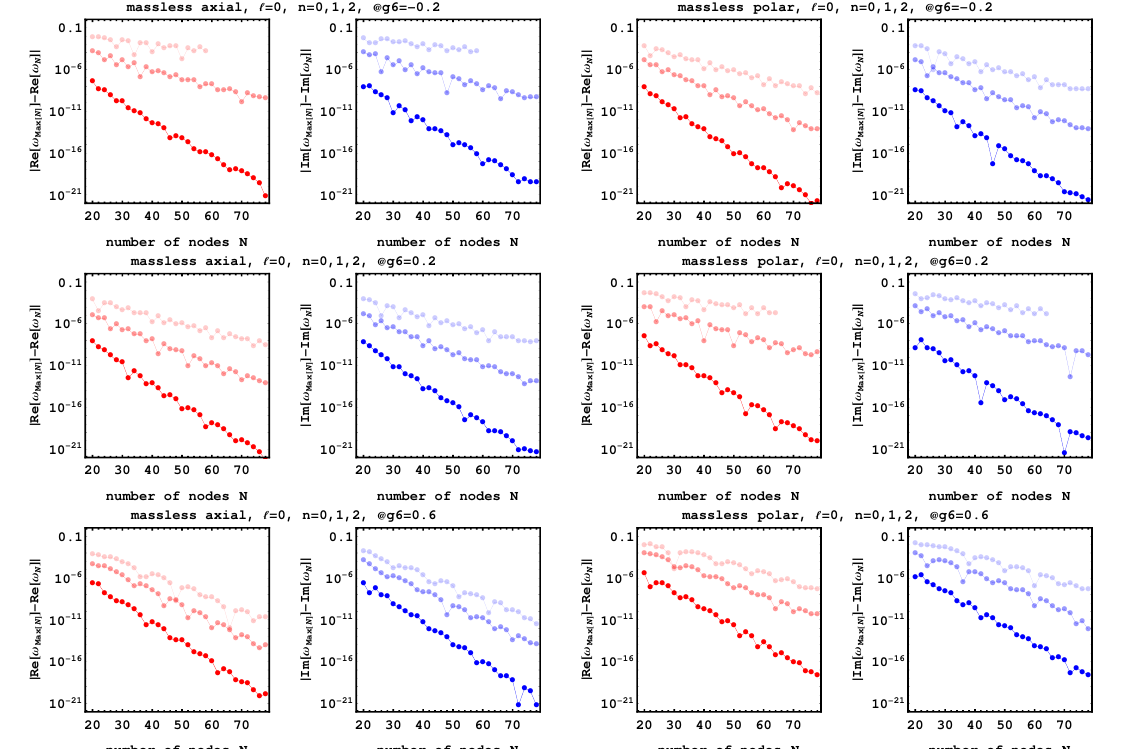
Figure 9 . Exponential convergence with growing number N of Chebyshev nodes for the massless axial and polar modes. The left two columns show real and imaginary parts of the massless axial mode. The right two columns show real and imaginary parts of the massless polar mode. From top to bottom, we show convergence plots for exemplary points at g 6 = − 0 . 2 , 0 . 2 , 0 . 6 . As in figure 5, increasingly light shading denotes increasing n . To aid direct visual comparison, we choose the same plot range on the